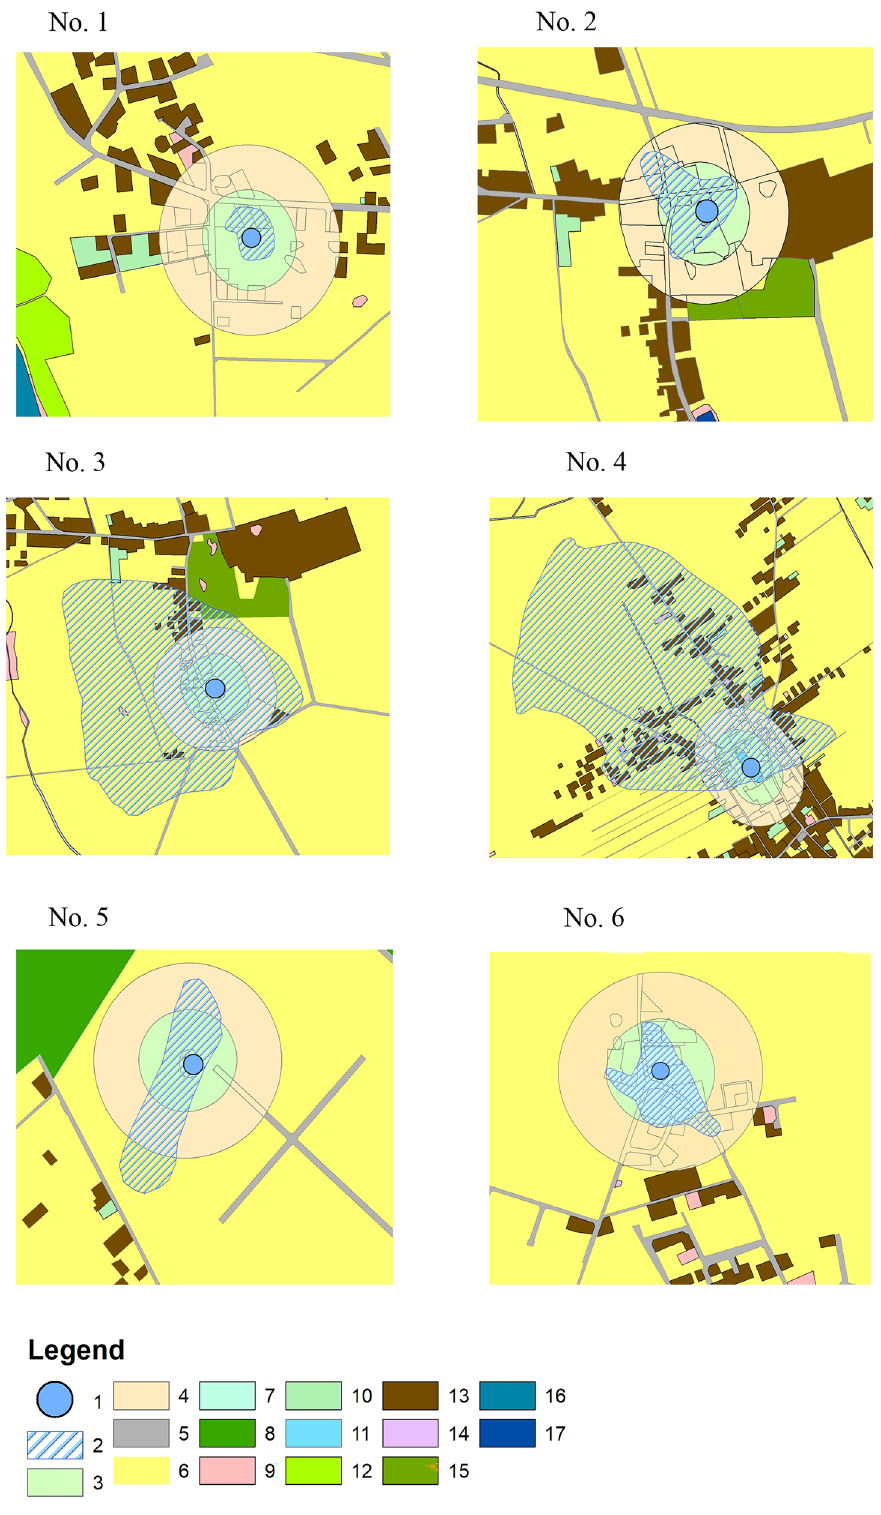
Figure 2. Land use in the 100- and 200-m buffer zones in the catchment areas. The map was generated by ArcGIS 10.6. https:// suppo rt. esri. com/ en/ Produ cts/ Deskt op/ arcgis- deskt op/ arcmap/ 10-6- 1# overv